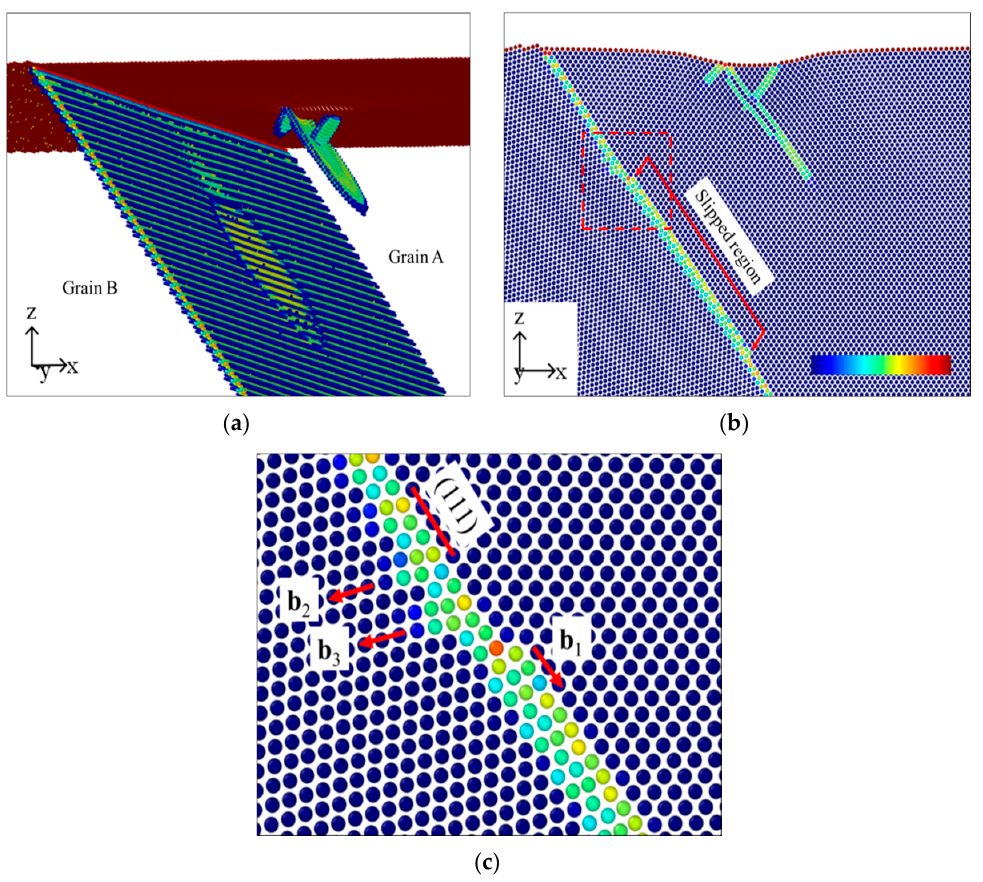
Figure 8. Atomic configuration during the indentation near ( Δ x = R ) the dense GB at δ = 0.85 nm. Atoms are colored according to CSP; x , y and z axes of the simulation cell are aligned with lattice directions (cid:4670)110(cid:4671) A , (cid:4670)1(cid:3364)10(cid:4671) A , and (cid:4670)001(cid:4671) A . ( a ) 3D view. fcc atoms are removed for the clarity of illustration; ( b ) cross-sectional view. Atoms on two adjacent (cid:4666)22(cid:3364)0(cid:4667) planes at the center of the bicrystal are shown along the along (cid:4670)11(cid:3364)0(cid:4671) tilt axis; and ( c ) the magnified view of the region marked with the dashed square in ( b ).